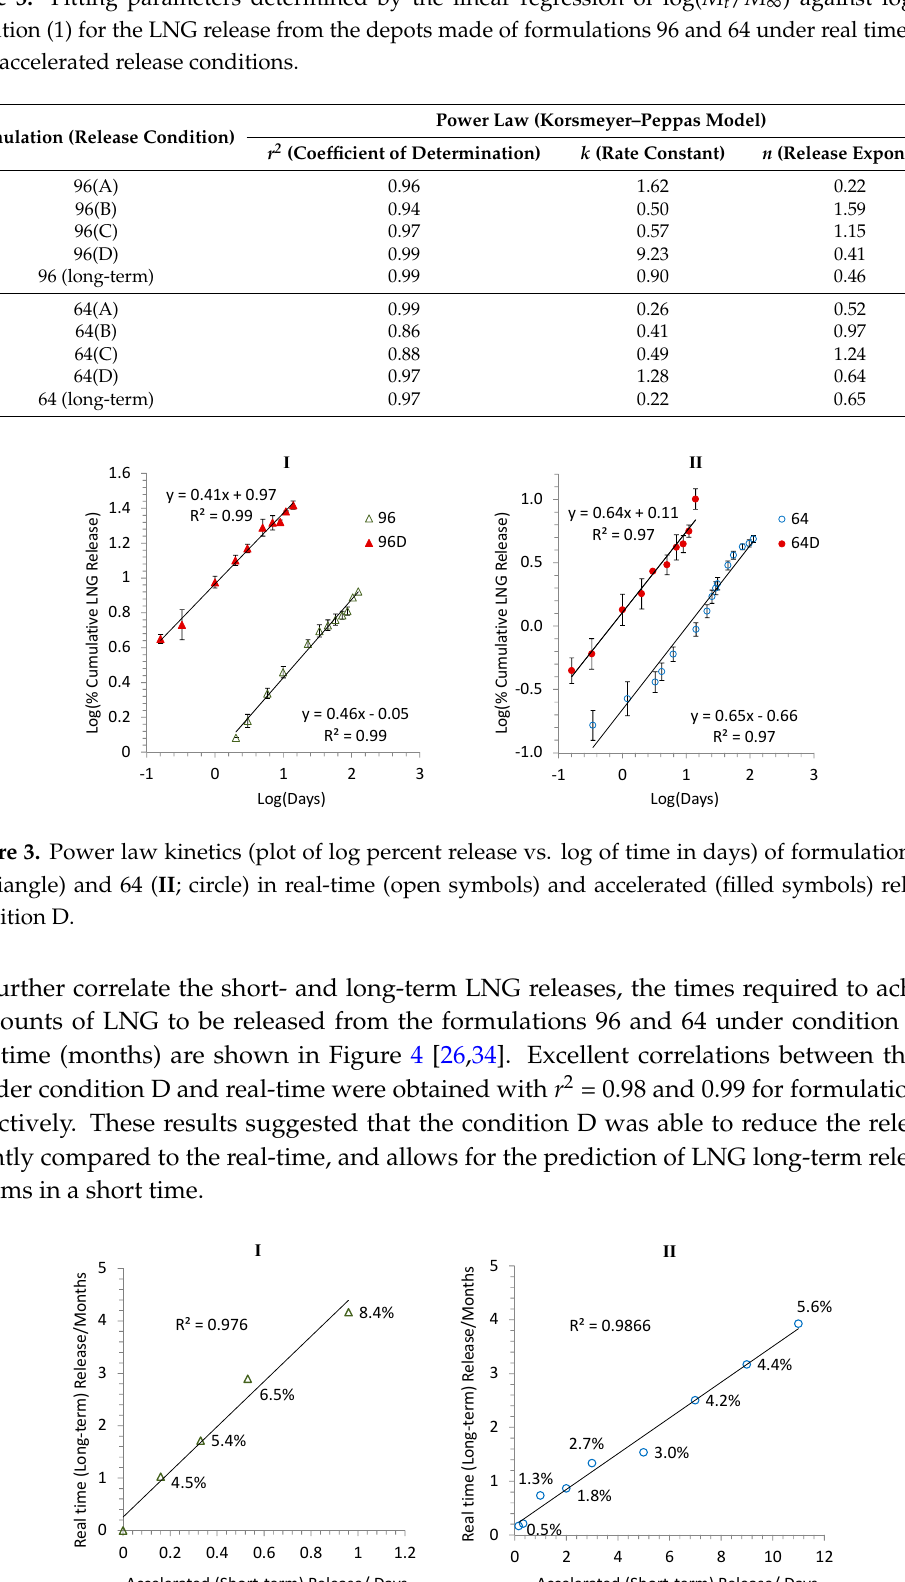
Figure 4. Correlation of accelerated (short-term) release at condition D with real-time (long-term) release testing of formulations 96 ( I ; triangle) and 64( II ; circle).